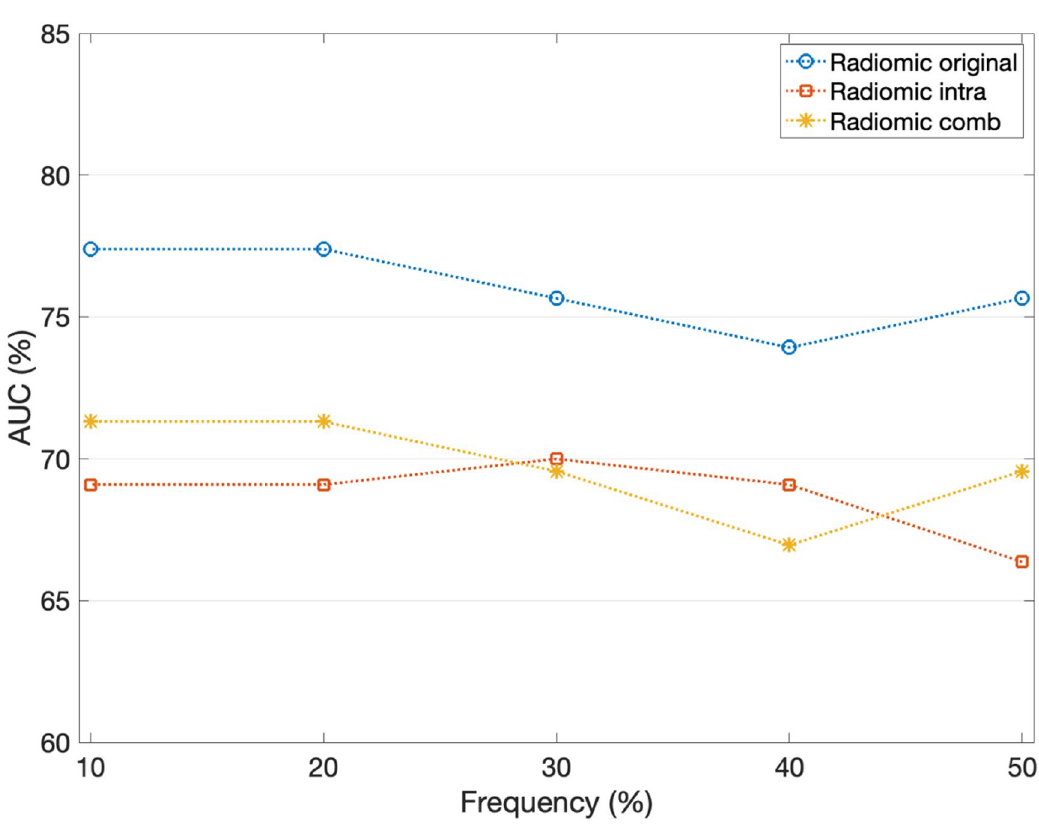
Figure 1. AUC distributions of some radiomic-based models on the hold-out test set by decreasing the number of features according to the feature selection frequency over the leave-one-out cross-validation rounds on the training